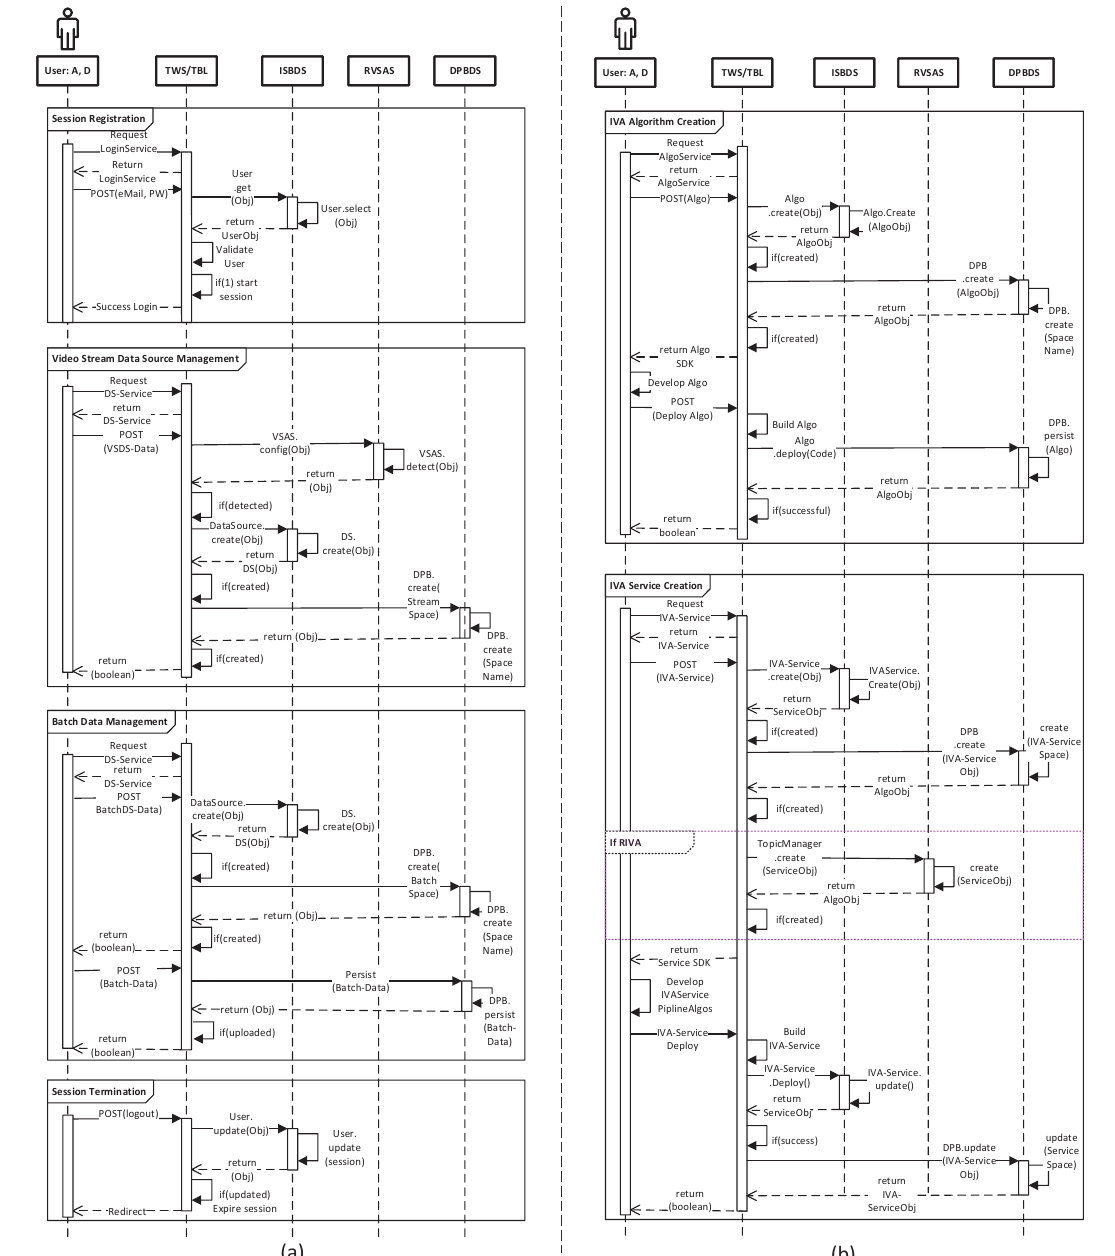
Figure 11. The sequence diagram for session creation, video stream data source, and batch data management are shown in ( a ). Similarly, the sequence diagram for the IVA algorithm and service creation is shown in ( b ). In the Actor lifeline, A and D represent Admin and Developer , respectively. These two roles are allowed to create a new video analytics algorithm and